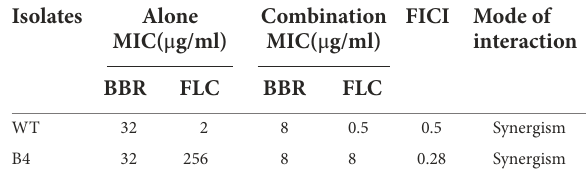
TABLE 2 Susceptibility activities of BBR and FLC alone and in combination against T. marneffei.